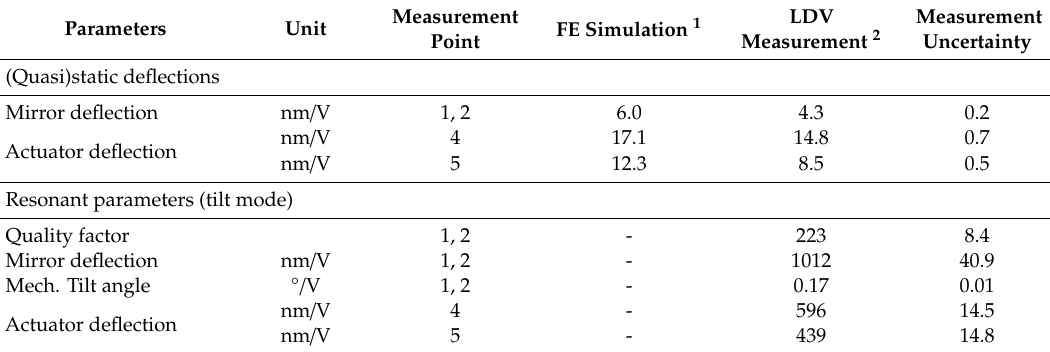
Table 5. Comparison of FE simulation 1 and LDV measurement of Design 1-S.